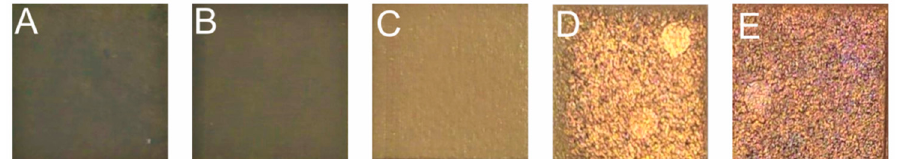
Figure 6. E ff ects of electroless metallization of the composites A, B, C, D, and E. Figure 6. Effects of electroless metallization of the composites A, B, C, D, and E.